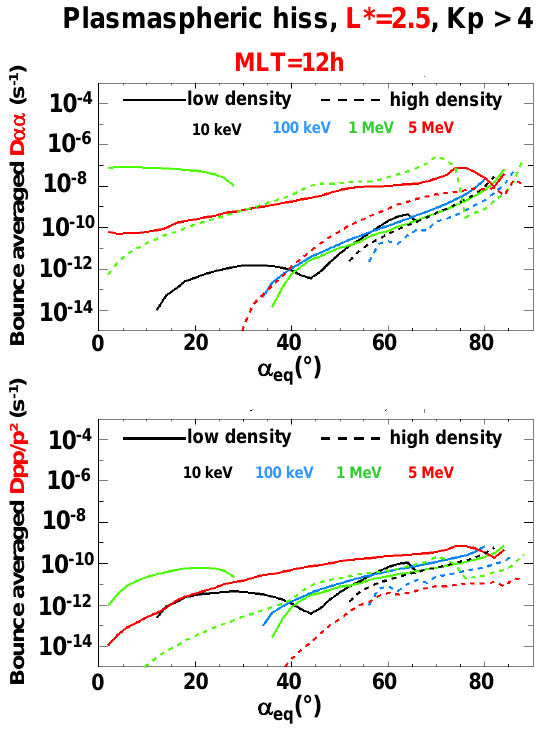
700 Figure 6. Bounce-averaged pitch angle (top) and energy (bottom) diffusion rates (s − 1 ) for plasmaspheric hiss using WAPI code for 4 Fig. 6 Bounce-averaged pitch angle (top) and energy (bottom) diffusion rates (s -1 ) for 701 energies, 0.01MeV (black), 0.1MeV (blue), 1MeV (green) for and 5MeV (red) L ∗ = 4.0, for MLT = 0h, for active magnetic activity plasmaspheric hiss using WAPI code for 4 energies, 0.01 MeV (black), 0.1 MeV (blue), 1 702 (Kp > 4) and for two different plasma densities: 5th percentile in solid lines and 95th percentile in dashed lines. MeV (green) for and 5 MeV (red) L*=4.0, for MLT=0h, for active magnetic activity (Kp>4) 703 (low density) in solid lines and 95th percentile (high density) in dashed lines for L ∗ = 2.5 (Fig. 5) and for L ∗ = 4 (Fig. and for two different plasma densities: 5 th percentile in solid lines and 95 th percentile in 704 dashed lines. 705